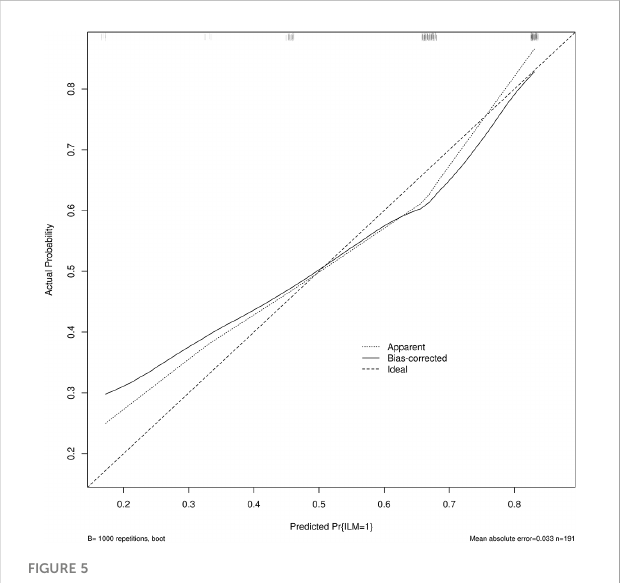
FIGURE 5 Calibration curve for predicting LNM. The nomogram predicted LNM is plotted on the x-axis, and the actual incidence of LNM is plotted on the y-axis. A plot along the 45° line will indicate a perfectly calibrated model where the predicted LNM is the same as the actual LNM. The expected probability distribution for the occurrence of LNM is shown at the top of the fi